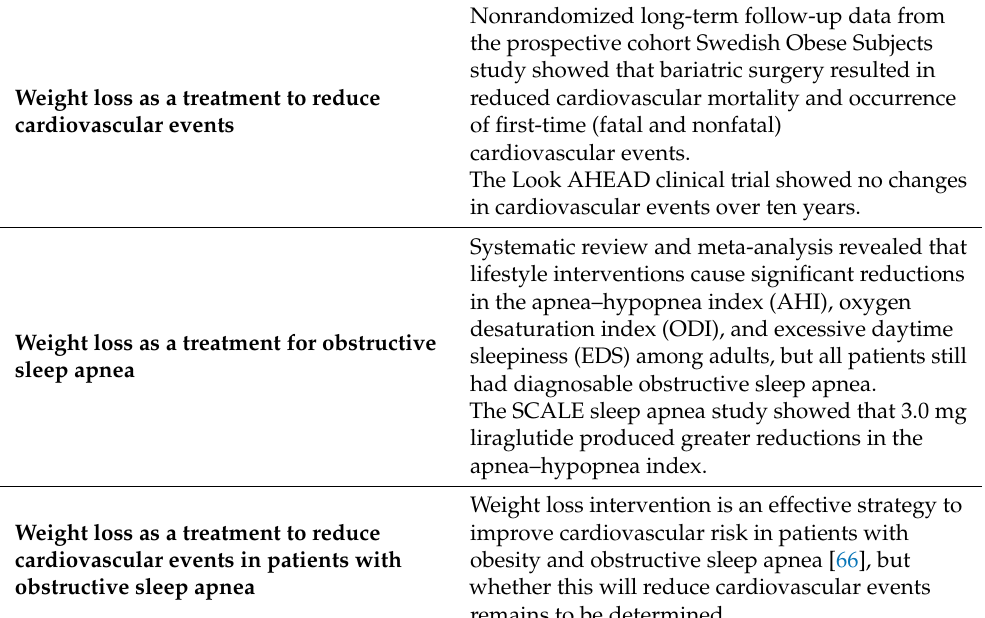
Weight loss as a treatment to reduce cardiovascular